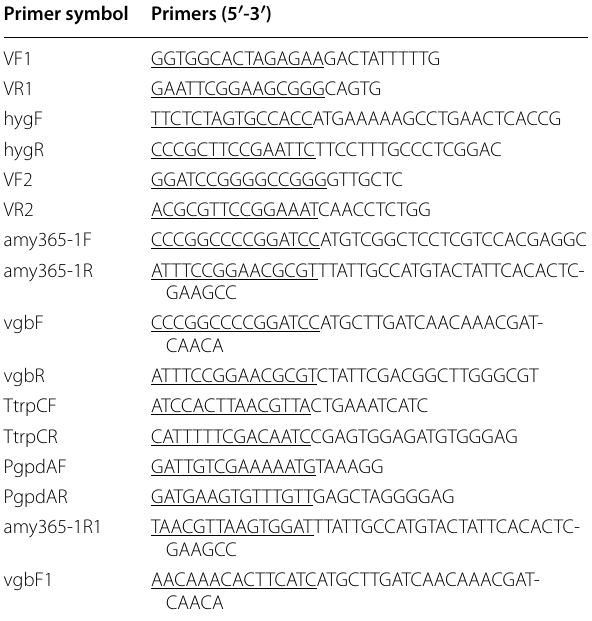
Table 1 Primers used for construction of overexpression plasmid Primer symbol Primers (5 ′ ‑3 ′